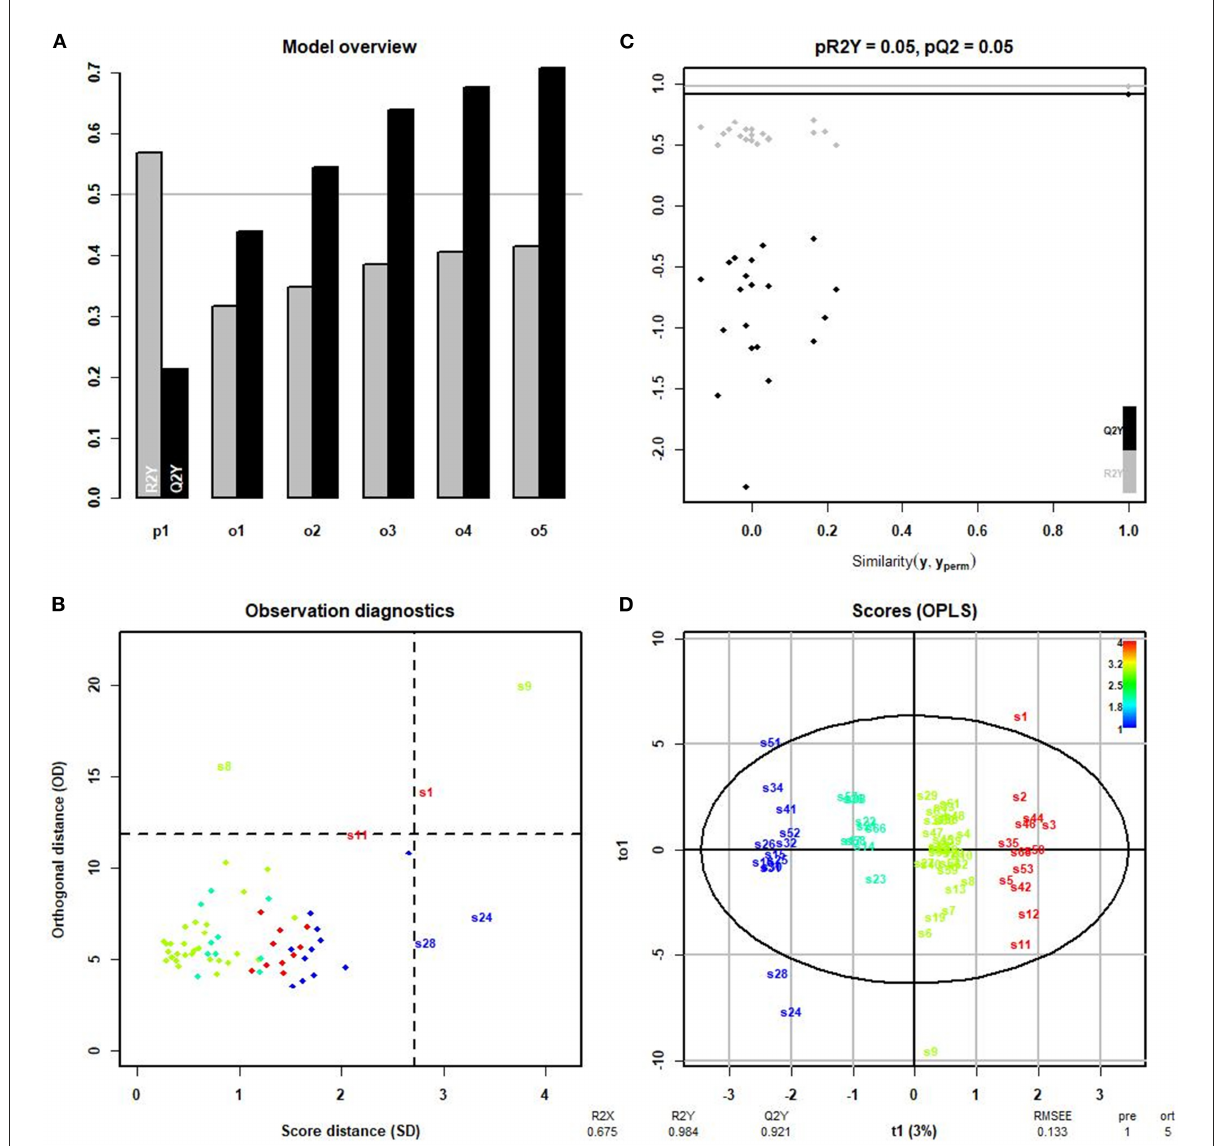
FIGURE5 OPLS-DA. (A) R2y and Q2y of five orthogonal axes. R2y represents the measured rate of the built model for the Y matrix. Q2y indicates the prediction ability of the model; the closer the value is to 1, the better the fitting degree of the model. (B) Samples differing markedly from other samples. S22, 18:0–18:1 PE; S43, 20:4 (Cis) PC; S47, 18:1–18:0PC. (C) Scatter plot showing that the results were stable without overfitting (pR2Y = 0.05, pQ2 = 0.05). (D) The four groups: group 1 = normal rotator cuff with normal clinical routine serum lipid test results; group 2 = normal rotator cuff with abnormal clinical routine serum lipid test results; group 3 = rotator cuff tear with normal routine serum lipid test results; group 4 = rotator cuff tear with abnormal routine serum lipid test results. Traditional abnormal clinical plasma lipid levels were defined as abnormal levels for at least two of four lipids (TG ≥ 1.70 mmol/L; TC ≥ 5.18 mmol/L; L-DLC ≥ 3.64 mmol/L; HDL-C ≤ 1.04 mmol/L). R2x = 0.512; R2y = 0.973; Q2y = 0.879. All values > 0.5 indicate that the four groups of samples differed significantly in the OPLS-DA score